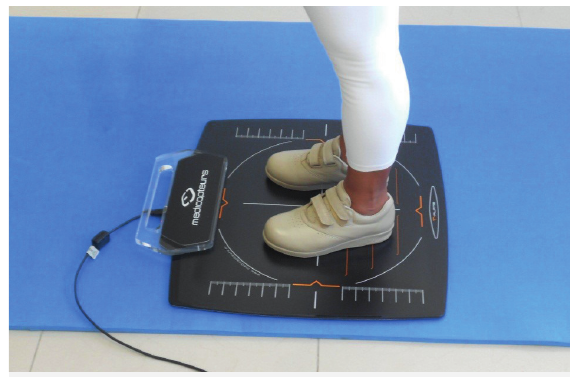
Figure 1 - Baropodometry platform being used for the measurement of the static plantar pressure with the use of footwear for diabetic foot.